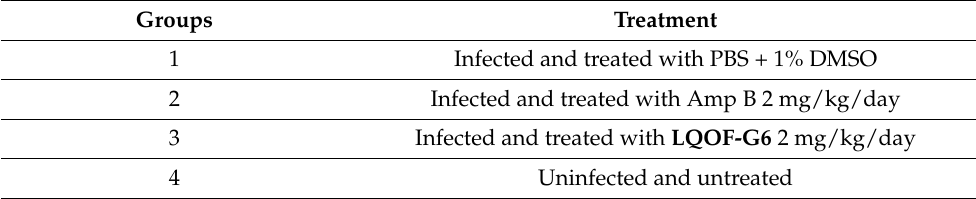
Table 1. Corresponding groups and treatments for the in vivo leishmanicidal activity test. Groups Treatment 1 Infected and treated with PBS + 1% DMSO 2 Infected and treated with Amp B 2 mg/kg/day 3 Infected and treated with LQOF-G6 2 mg/kg/day 4 Uninfected and